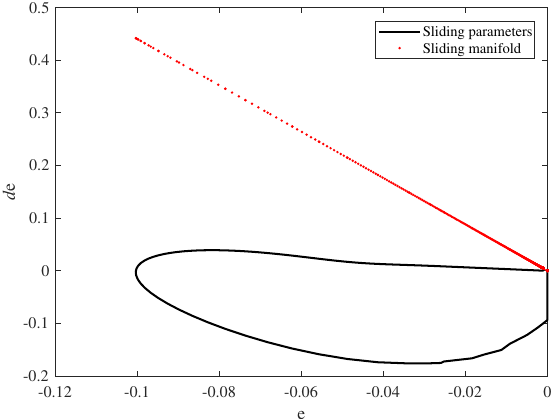
Figure 13. The ternary phase diagram of e -